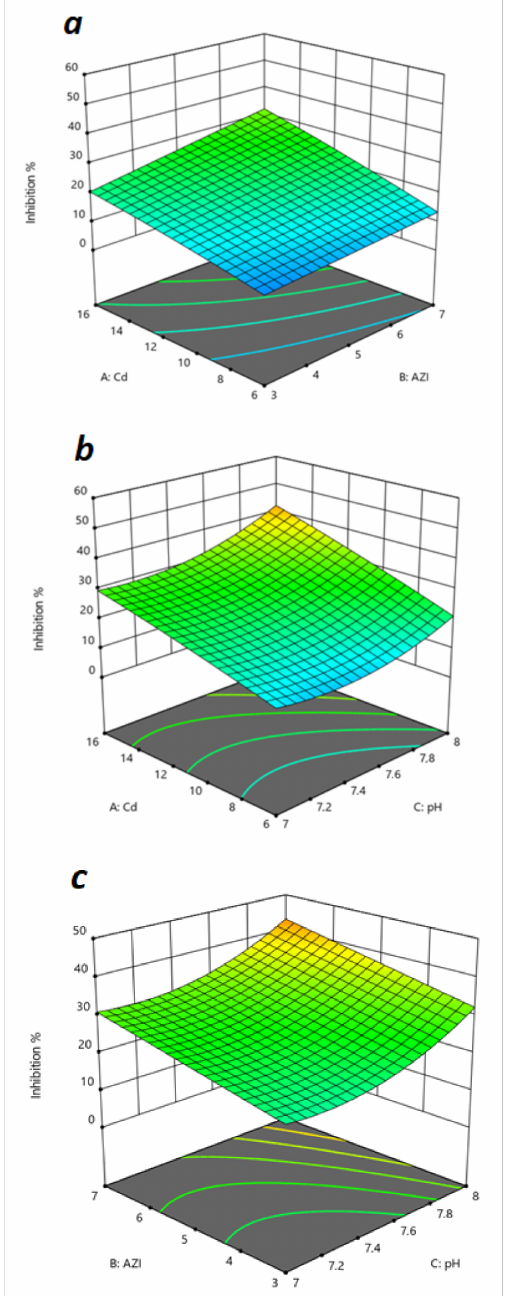
Figure 4. Interaction effects of Cd, AZI contamination, and soil pH on PNR inhibition (( a ): PNR inhibition effect of Cd and AZI for soil samples at pH 7; ( b ): PNR inhibition effect of Cd and pH, for 6mg/kg AZI contamination; ( c ): PNR inhibition effect of AZI and pH for 15 mg/kg Cd